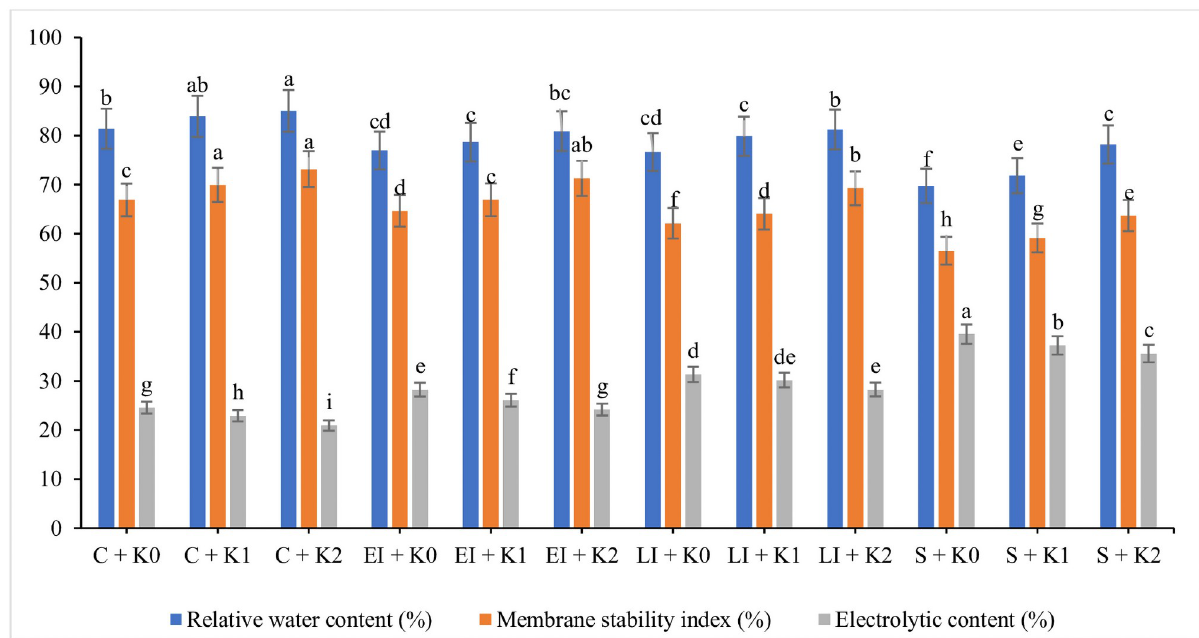
Fig 2. Mean values of the relative water content (%), membrane stability index (%) and electrolytic content (%) of the 12 treatments with different levels of irrigation (C = Control, EI = Early irrigation, LI = Late irrigation, S = Stress) and different amounts of K (kg ha –1 K 2 SO 4 ): (K 0 = 0; K 1 = 10; K 2 =